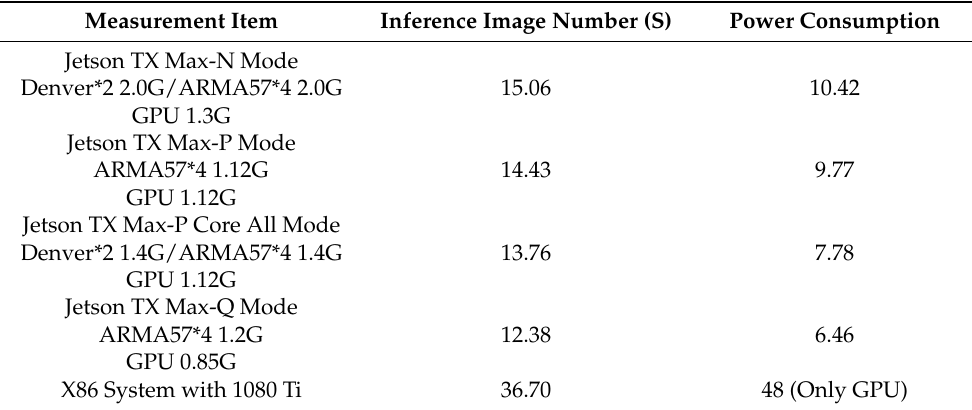
Table 3. Single-server power